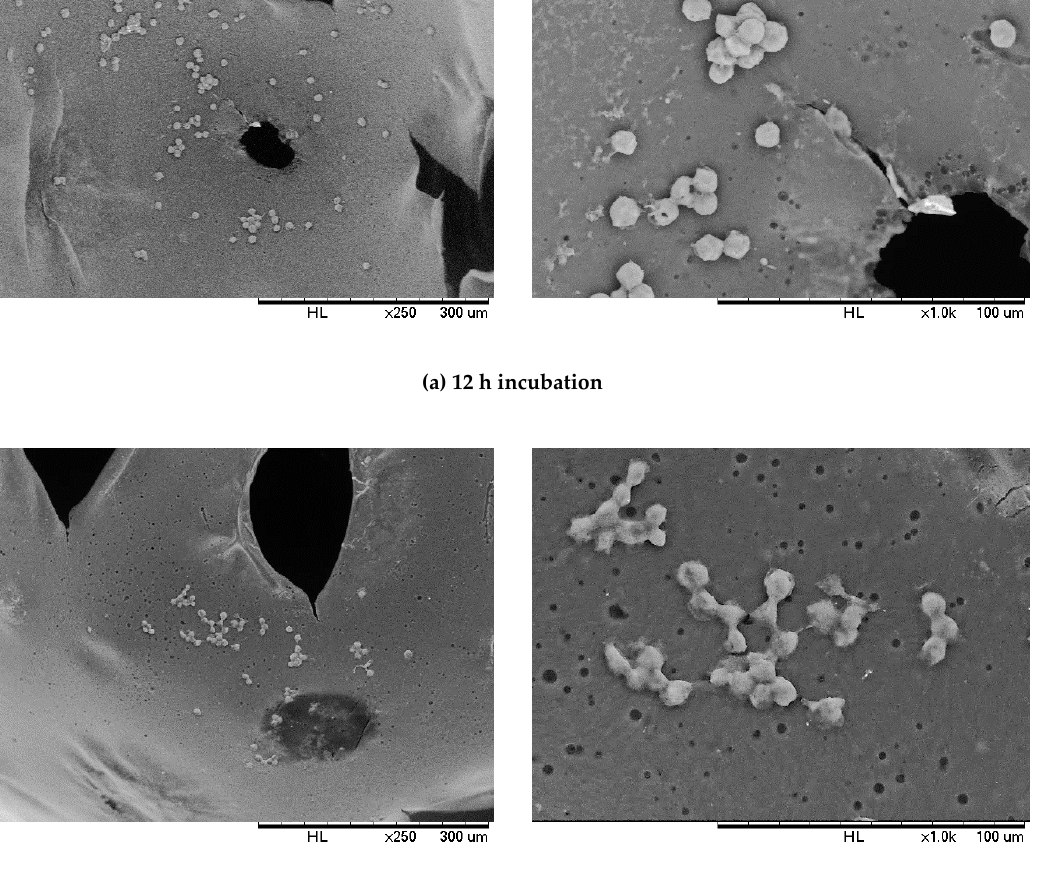
Figure 12. SEM images of MG-63 cells adhesion on PU 1.0 after ( a ) 12 h and ( b ) 24 h of incubation